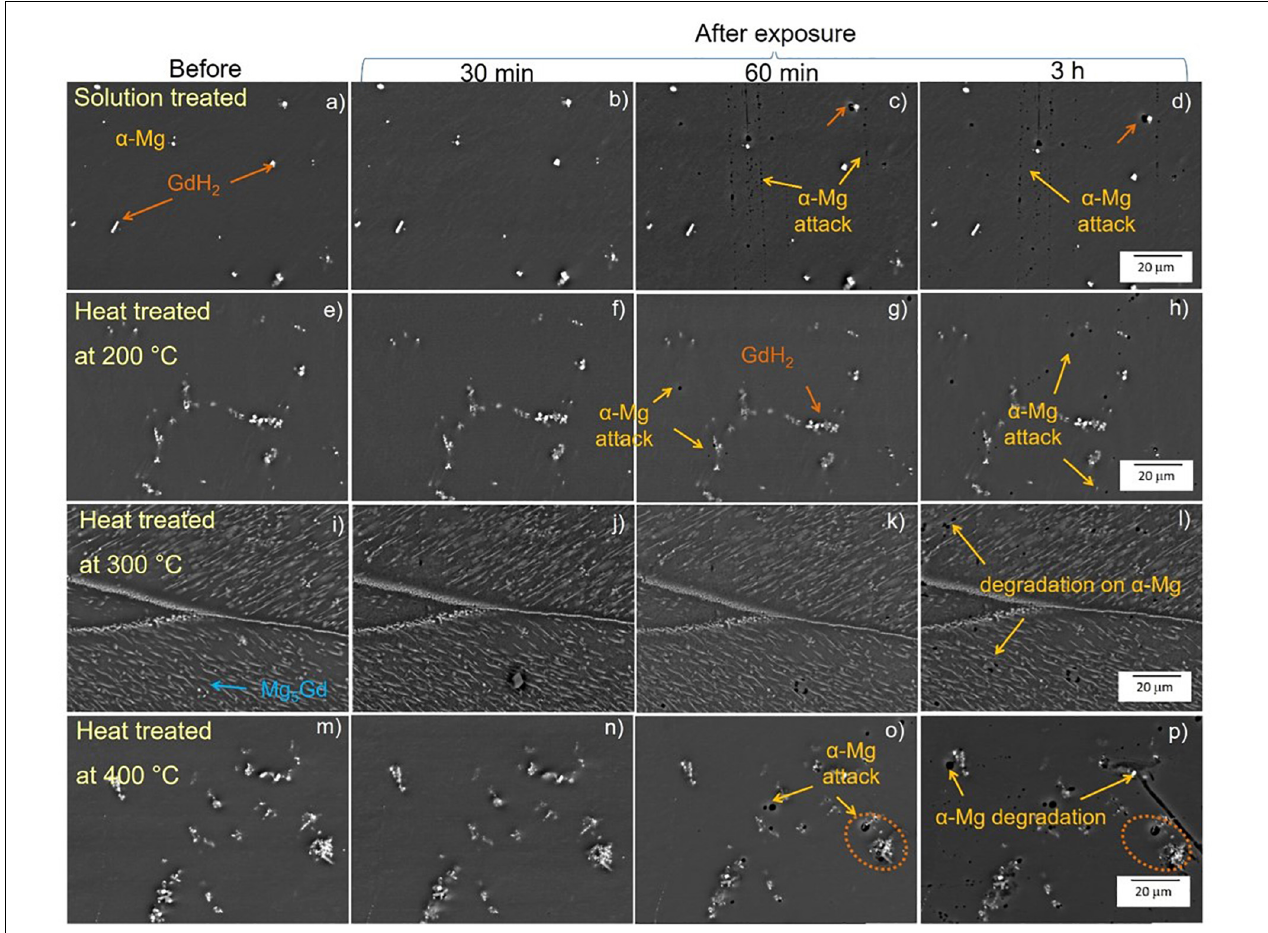
FIGURE 12 | Corrosion monitoring using drop test of solution treated (a–d) and heat treated at 200 ◦ C (e–h) , 300 ◦ C (i–l) and 400 ◦ C (m–p) of Mg-10Gd alloy after 30, 60 min and 3 h time exposure in 0.5 wt.% NaCl solution. Yellow arrows depict the corrosion attack on the α - Mg matrix, orange arrows/dotted circles indicate corrosion process on the GdH 2